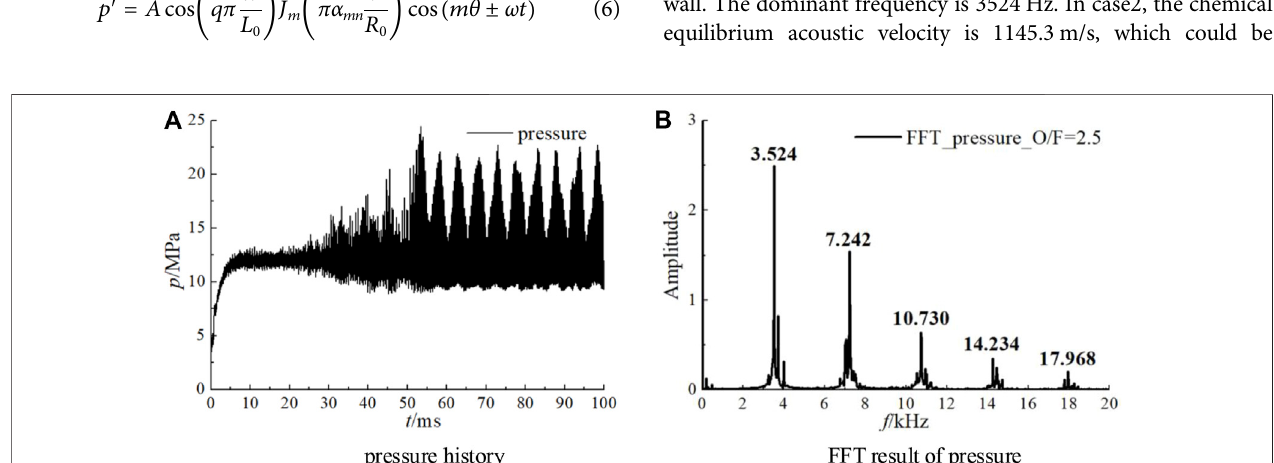
FIGURE 7 | Pressure history and its FFT result of case2 (probe is near the wall and 50 mm downstream from injector faceplate). (A) pressure-time trace. (B) FFT result of pressure.